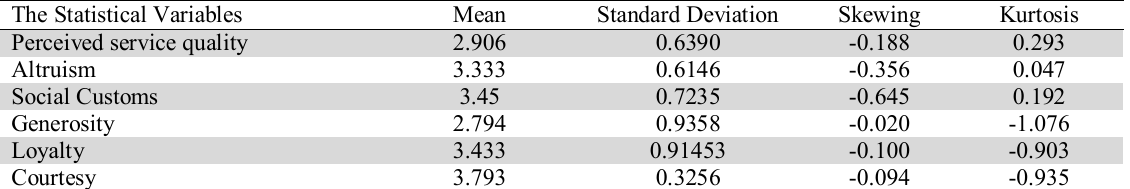
The summary of some basic statistics